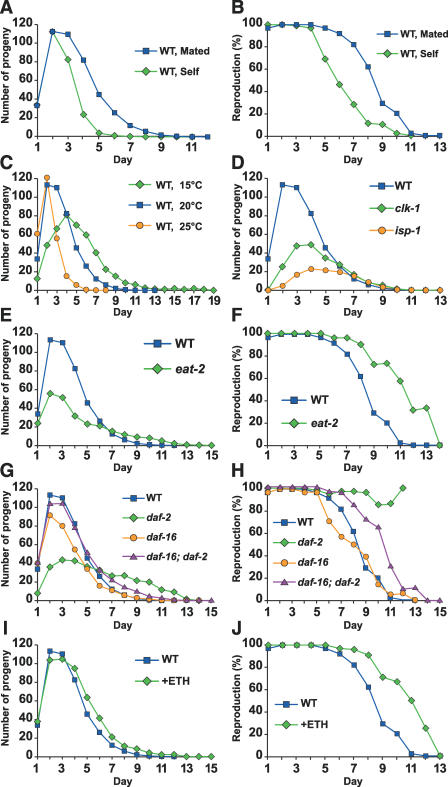
Reproductive Activity of C. elegans Hermaphrodites(A), (C–E), (G), and (I) show average daily progeny production of live hermaphrodites. (B), (F), (H), and (J) show the percentage of live hermaphrodites producing progeny. The daf-2 plot (H) does not end at zero percent because no daf-2 hermaphrodites survived beyond day 12. Number of hermaphrodites at the start of the experiment is presented in Table 1. Hermaphrodites were mated for days 1 and 2 to three wild-type (WT) males, except data labeled Self. Studies were conducted at 20 °C, except data labeled 15 °C and 25 °C. The mutant alleles were isp-1(qm150), clk-1(qm30), eat-2(ad465), daf-2(e1370), and daf-16(mu86). Wild-type hermaphrodites were exposed to 2 mg/ml ethosuximide (+ETH) from conception until death (I and J).